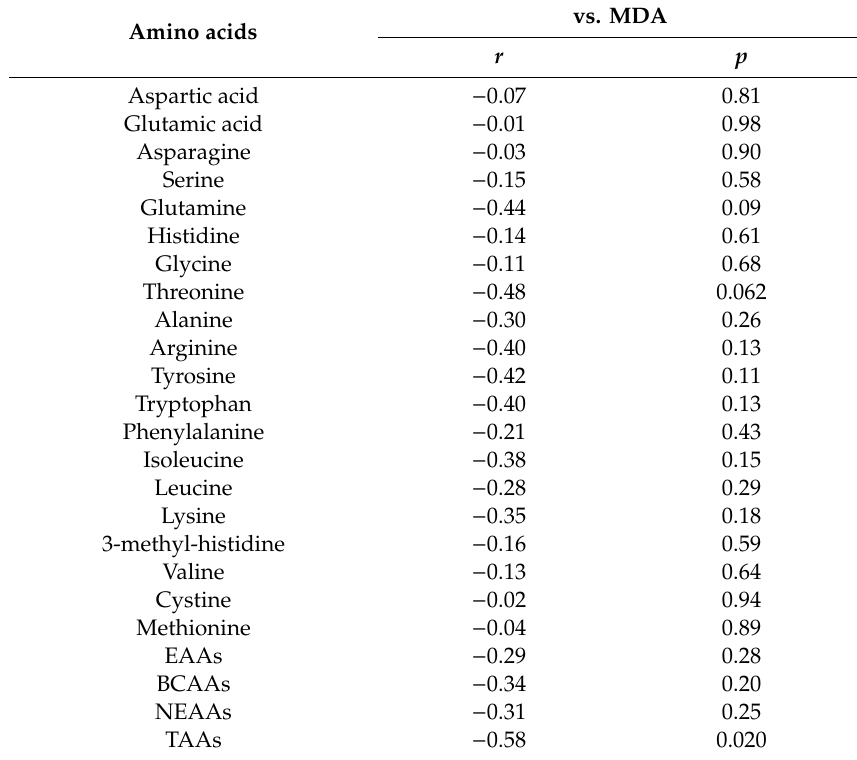
Table 7. Correlations (Pearson r ) between plasma amino acid and malondialdehyde (MDA) found in the patient Group at phase B, phase C and phase